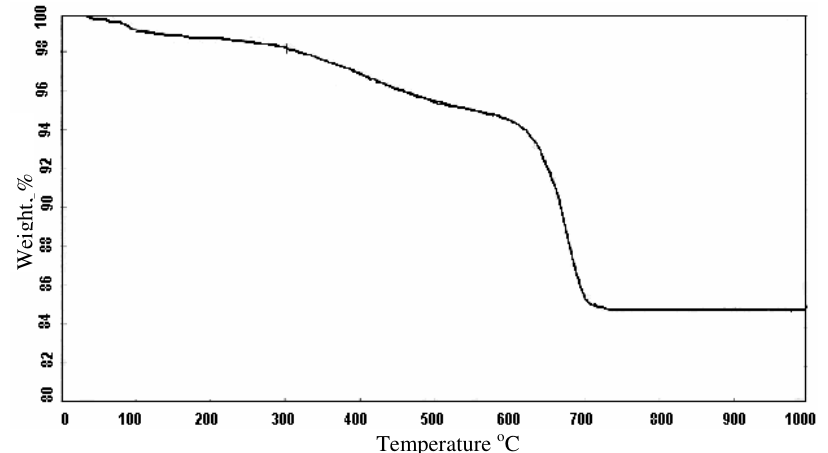
Figure 5. Weight-temperature behavior of gallosilicate nitrate